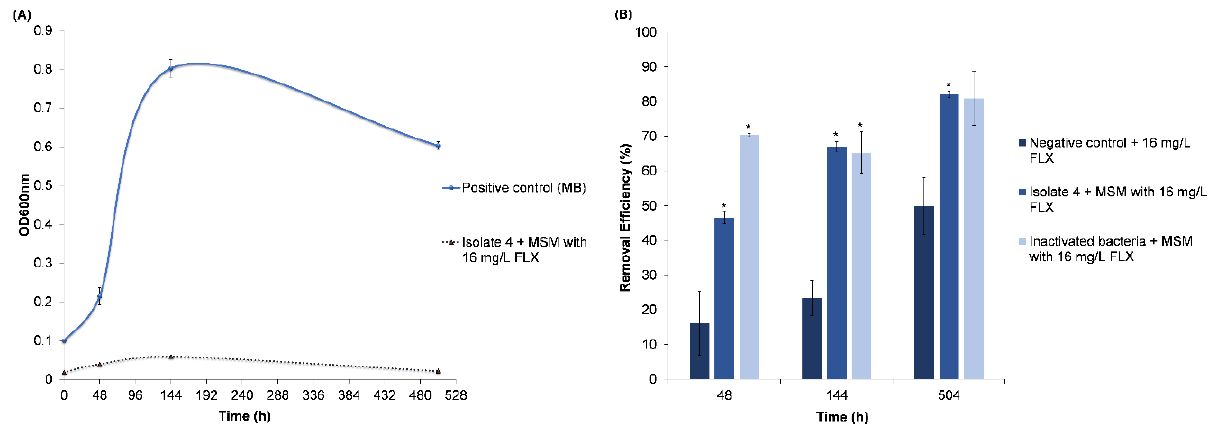
Figure 4. Representation of the bacterial growth curve ( A ) and removal efficiency in percentage ( B ) in the presence of fluoxetine over 504 h (21 days) of assay. Asterisks indicate a significant difference compared to the control at p < 0.05 *. Values are expressed as the mean ± standard error (n = 3). In cultures using 100 µL of M. yunnanensis strain TJPT4 in the presence of 16 mg/L, the removal efficiencies were 47 ± 2%, 67 ± 2% and 82.1 ± 0.9% after 48, 144 and 504 h, respectively (Figure 4). The removal efficiency was 82% at a rate of 0.0538 d −1 , with an R 2 of 0.9562 and a t 1/2 of 13 days (Figure 4). In this assay, 100 µL of inoculum was used to avoid/prevent adsorption effects that can be enhanced with high amounts of biomass, and